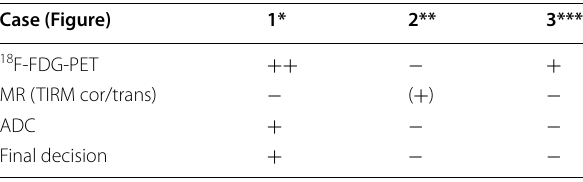
Table 3 Summary of the decision‑making process in case of discrepancies between 18 F‑FDG‑PET and MR concerning lymph node